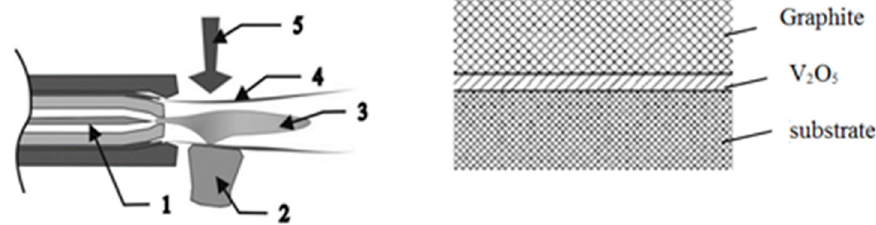
Figure 3. Coating process and the coating composition: (1) cathode, (2) anode, (3) plasma jet, (4) protective inert gas stream, (5) sprayed material.